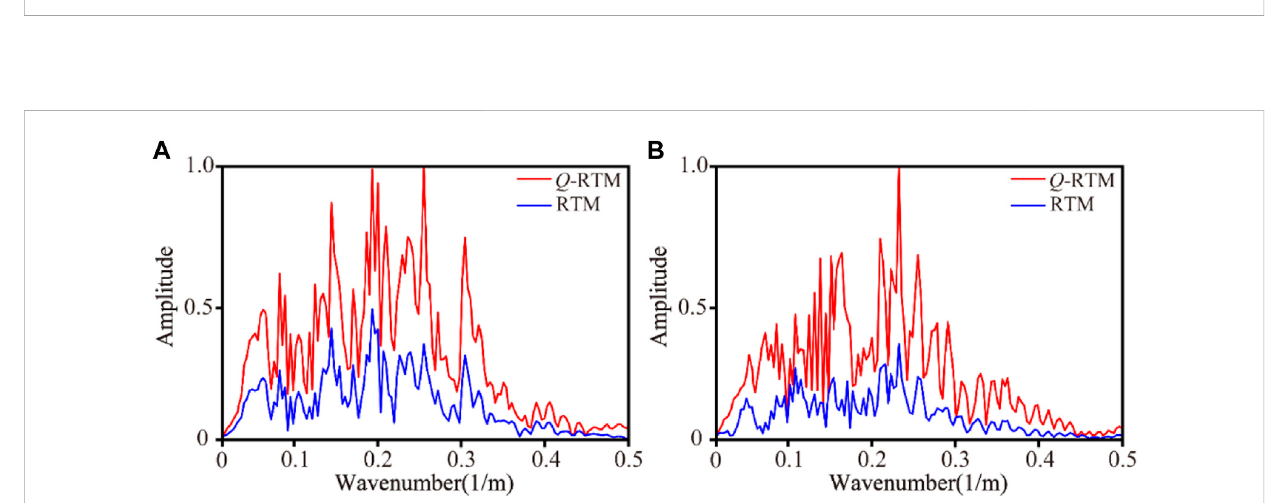
FIGURE 18 Amplitude spectra corresponding to the migrated seismic traces (A) at x = 5 km; (B) at x = 9 km.